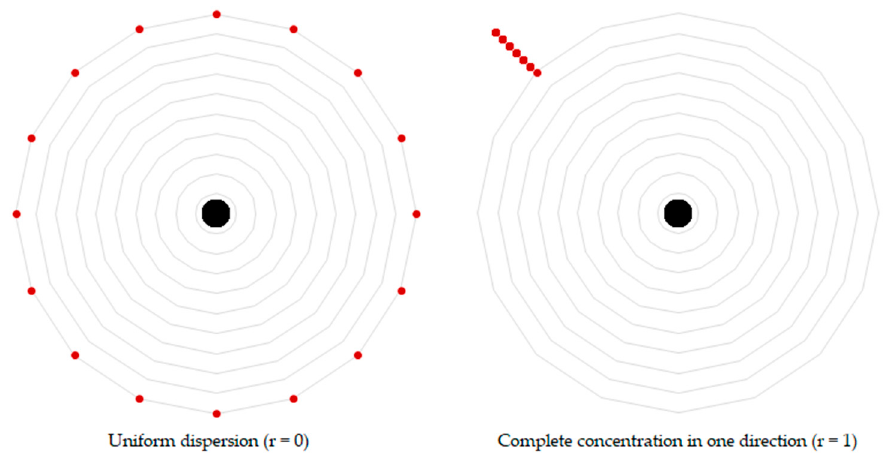
Figure 4. Calculating angular dispersion. The measure describes the dispersion of intersection points (red circles) in relation to the sample point in the center (black circle).